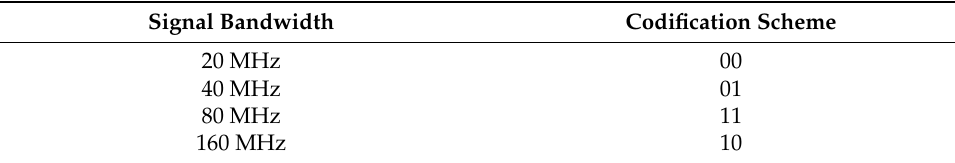
Table 1. Codification scheme.